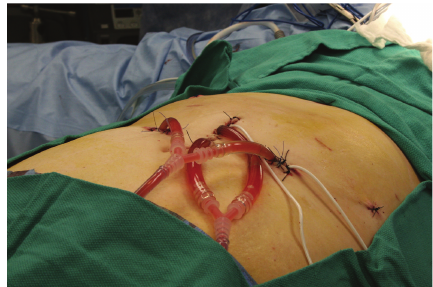
Figure 2: Laparoscopic hyperthermic intraperitoneal chemother- apy